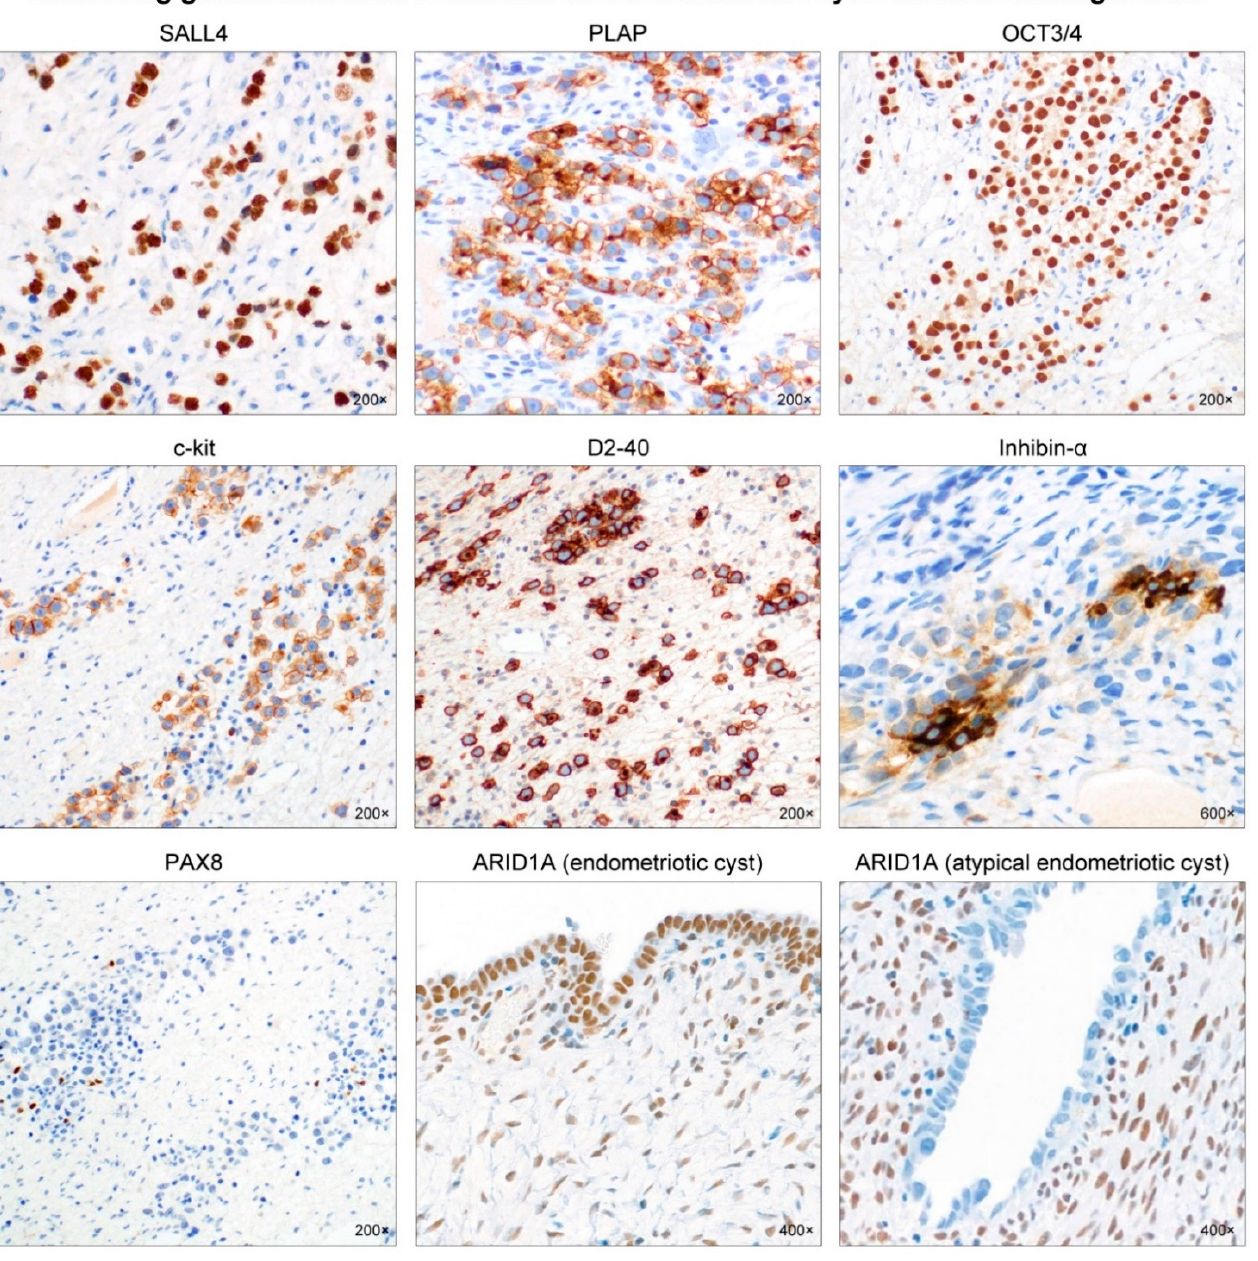
Figure 3. Immunostaining results. The neoplastic germ cells were positive for spalt-like protein 4 (SALL4), placental alkaline phosphatase (PLAP), octamer-binding transcription factor 3/4 (OCT3/4), c-kit, and D2-40. Some sex cord cells between germ cell nests expressed inhibin- α . The neoplastic germ cells were negative for paired box 8 (PAX8), a Mullerian-lineage epithelial marker. AT-rich interaction domain 1A (ARID1A) expression was uniformly positive in the glandular epithelium of typical endometriotic cyst, whereas ARID1A immunoreactivity was absent in the lining epithelium of atypical endometriotic cyst.